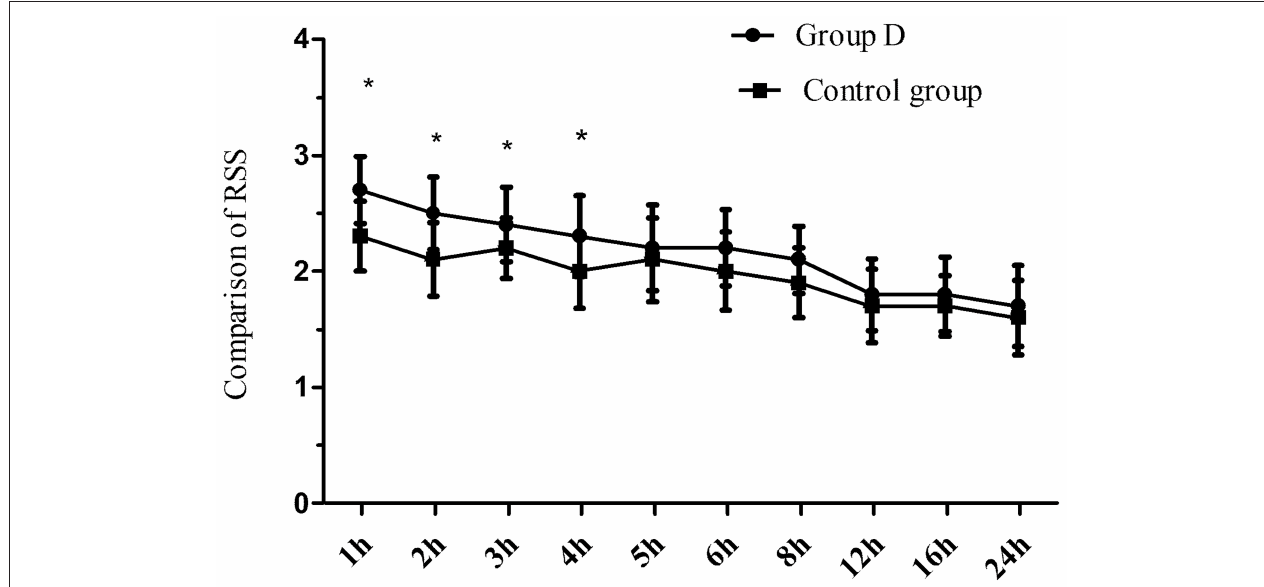
FIGURE 2 | A comparison of the postoperative RSS at different time points, * p < 0.05.